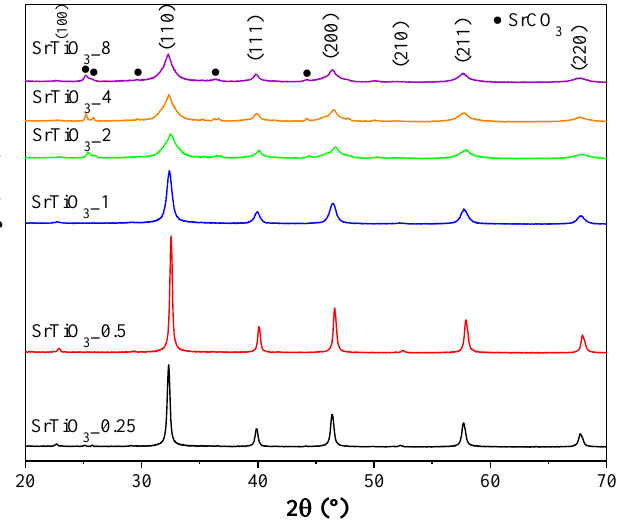
Figure 1. XRD patterns of SrTiO 3 photocatalysts prepared at various EG:H 2 O ratios. Table 1. Dependence of structural properties, optical properties, photocatalytic activity, and